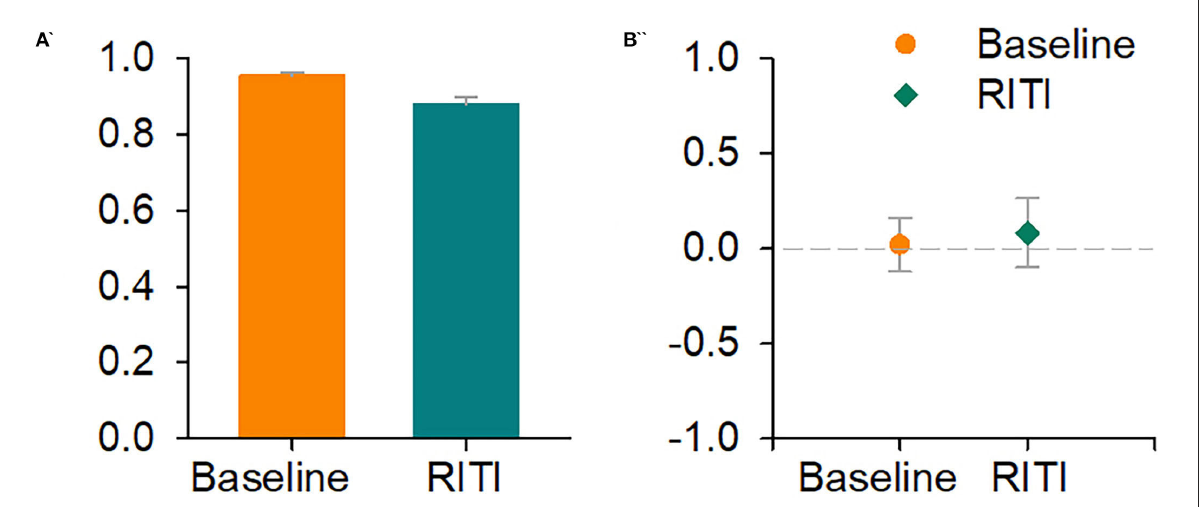
FIGURE2 Signal Detection Theory-based analysis: Indices of sensitivity (A ′ ) and response bias (B ′′ ) . Left panel shows A ′ at baseline (orange bar) and on RITI (green bar). The right panel shows B ′′ at baseline (orange circle) and on RITI (green diamond). The vertical bars of both panels represent